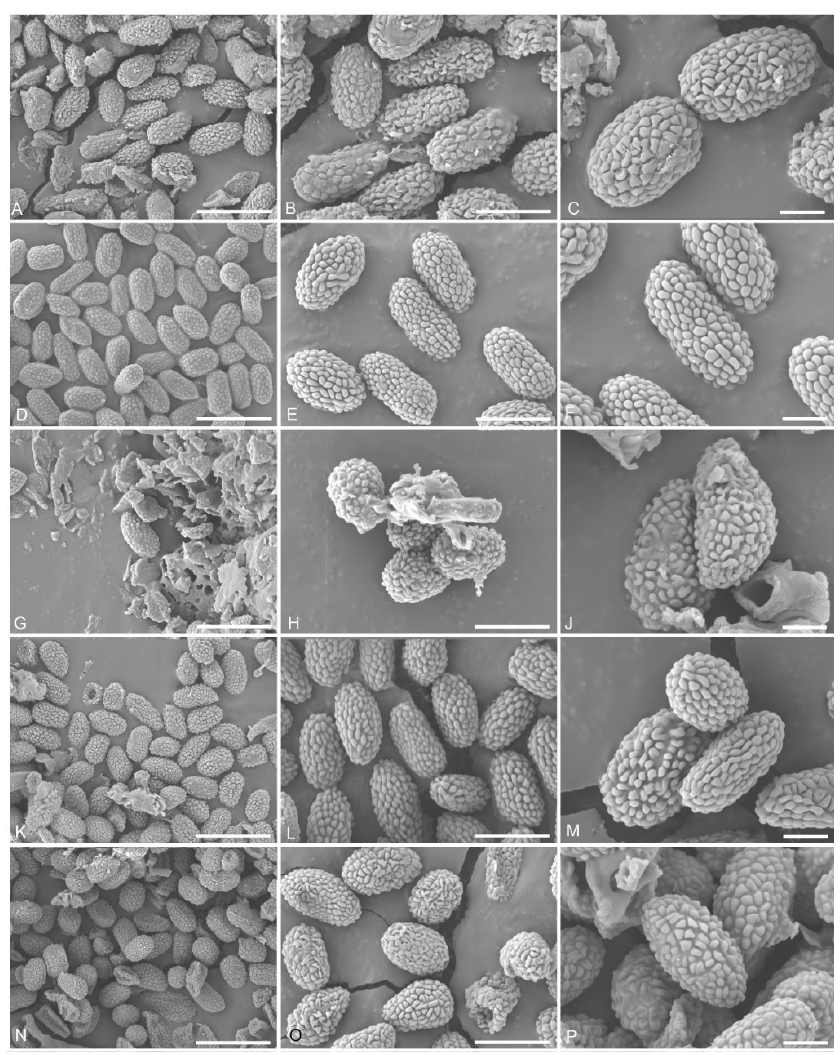
Figure 7. Ascospores of Pyrgidium species under SEM. ( A – C ). Kurz 1866, ( D – F ). Lindig 2865, ( G – J ). MFLU 21-0135, ( K ). L-996762, ( L , M ). Tibell 8306, ( N ). Tibell 8232, ( O ). L-008798, ( P ). L-996762. Scale bars: ( A , D , G , K , N ) = 10 µm, ( B , E , H , L , O ) = 5 µm, ( C , F , J , M , P ) = 2 µm.